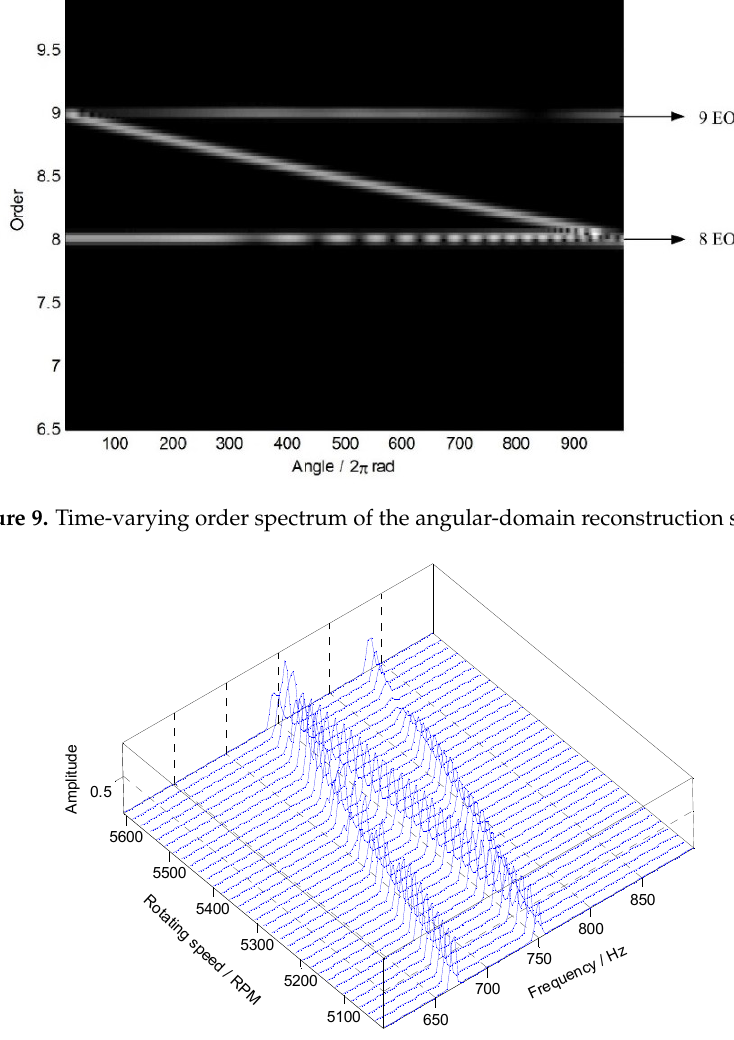
Figure 10. Waterfall of the angular-domain reconstruction signal based on STFT.